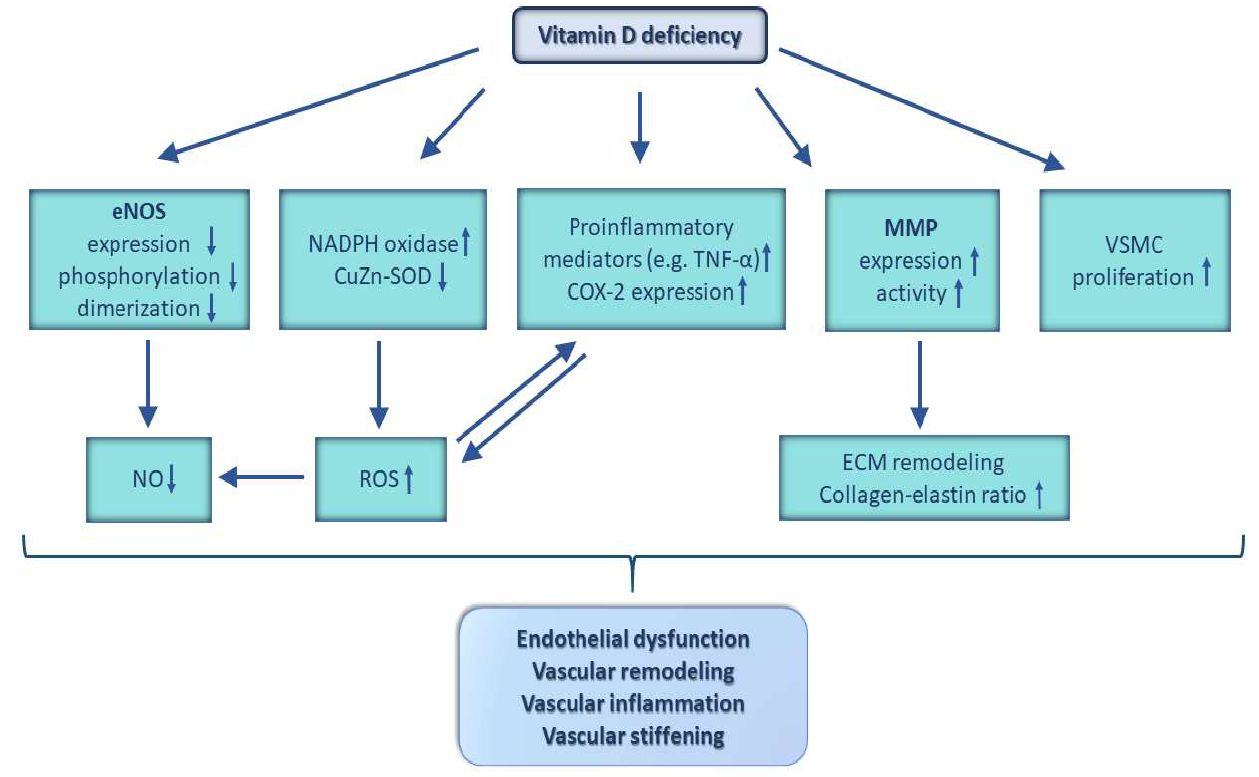
Figure 3. Representative actions of vitamin D deficiency in the (cerebro)vascular wall. Vitamin D deficiency impairs vascular functions via several pathways, including reductions in nitric oxide (NO) production, due to decreased endothelial nitric oxide synthase (eNOS) expression, phosphorylation, and dimerization. In addition, enhanced level of reactive oxygen species (ROS), resulting mainly from decreased expression of cytosolic copper-zinc superoxide dismutase (CuZn-SOD) and upregulation of the free radical generating nicotinamide adenine dinucleotide phosphate (NADPH) oxidase enzyme and its subunits in endothelial cells, contributes to endothelial dysfunction. Furthermore, vitamin D deficiency is associated with increased production of pro-inflammatory mediators, for instance, tumor necrosis factor-α (TNF-α) and cyclooxygenase 2 (COX-2), leading to vascular inflammation. Remodeling of extracellular matrix (ECM) and increased collagen–elastin ratio of vessel wall—particularly due to altered expression and activity of specific matrix metalloproteinases (MMPs)—as well as changes in vascular smooth muscle cell (VSMC) proliferation, may result in vascular remodeling and stiffening.